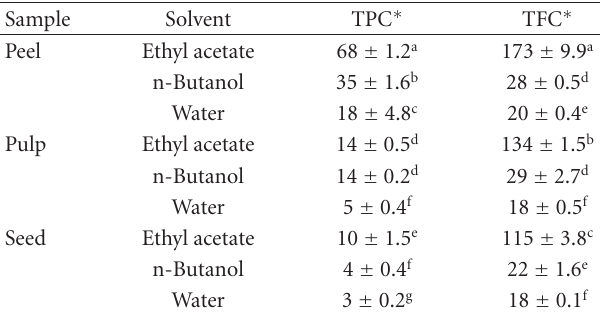
Table 1: Total phenolic and flavonoid content of Canarium odonto- phyllum